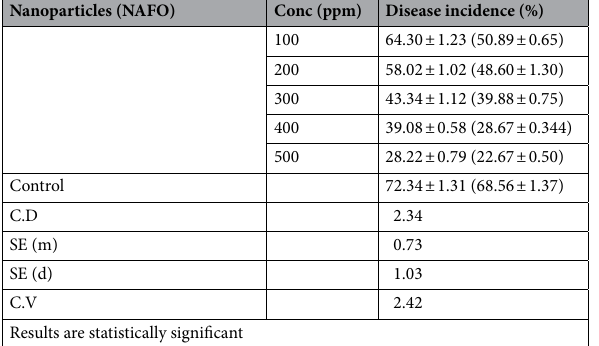
Table 4. Evaluation of NAFO nanoparticles under pot culture conditions against dry rot of ginger ( F. oxysporum ) (Figures in the parentheses are angular transformed